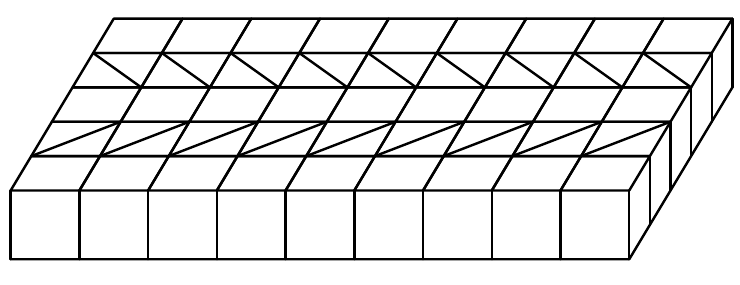
Fig. 10: Layer of unit cubes and triangular prisms.